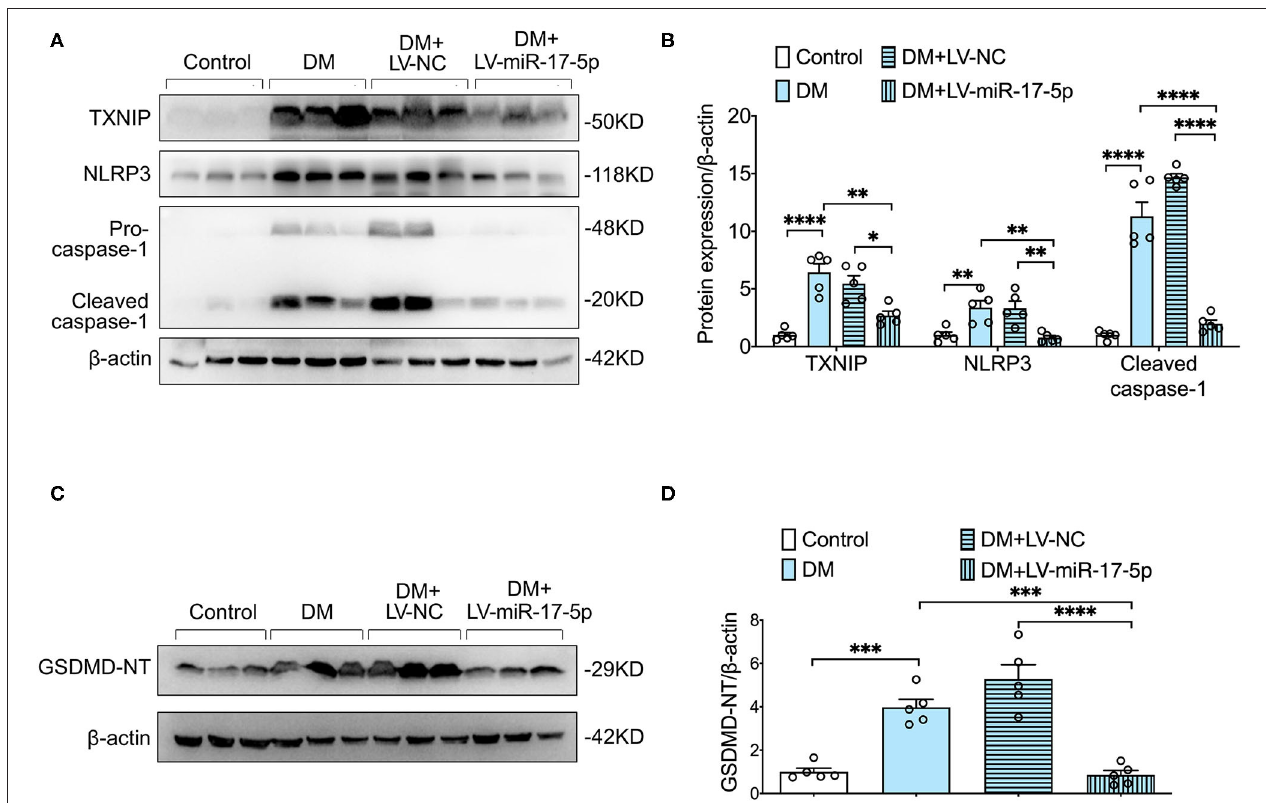
FIGURE 5 | Overexpression of miR-17-5p ameliorated NLRP3 inflammasome-mediated pyroptosis, and suppressed TXNIP expression in DM. (A,B) Representative blots and quantitative analysis showing the expression of NLRP3, the cleavage of caspase-1, and TXNIP. (C,D) GSDMD. * p < 0.05, ** p < 0.01, *** p < 0.001, and **** p <